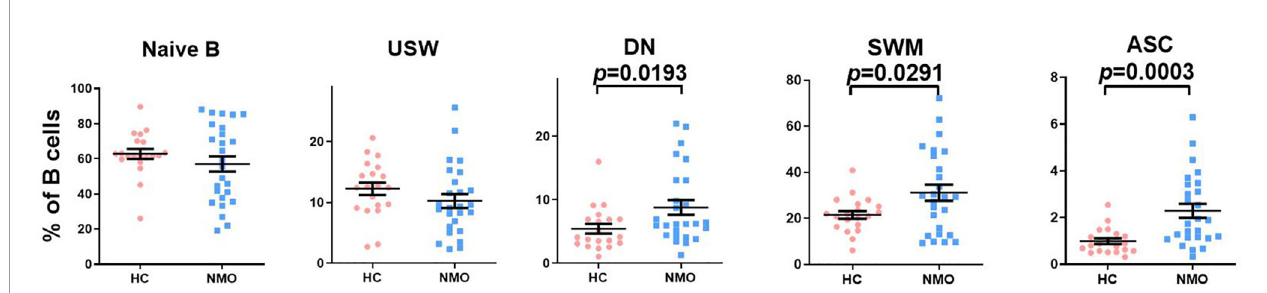
FIGURE 1 | The comparison of B cell subsets distribution in healthy controls and patients with NMOSD. Proportions of CD27 - IgD + naïve B cell, CD27 + IgD + unswitched memory B (USW), CD27 - IgD - double negative B cell (DN), CD27 + IgD − switched memory B (SWM) cells and CD27 high CD38 high autoantibodies secreted cells (ASC) among total B cells in patients with NMOSD and healthy controls (HC). Unpaired, two-tailed Student ’ s t tests were used. HC: n=20;